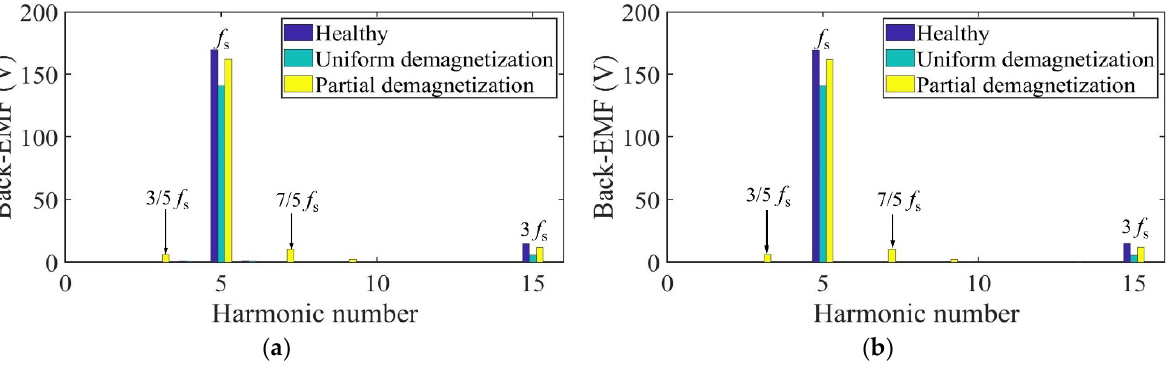
Figure 21. Harmonics in the back-EMF relative to fundamental wave at fs = 166.67 Hz. ( a ) Analytical model; ( b ) FE model.